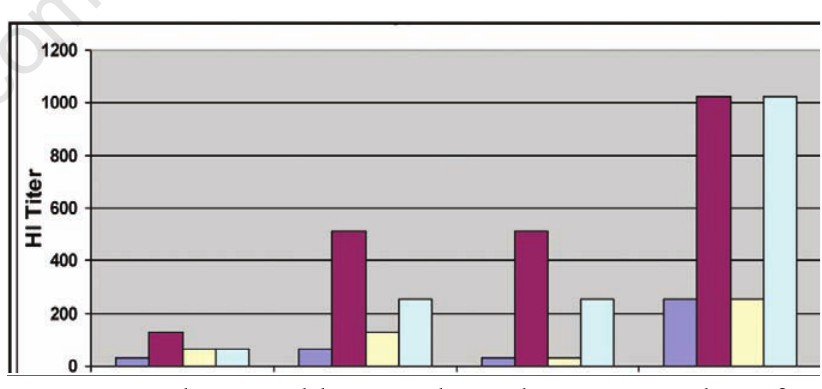
Figure 1. Hem-agglutination inhibition titer showing the antigenic interrelation of H9 subtype virus isolated in lahore in 2009. Table 3. Hemagglutination inhibition activity of pakistani h9 subtype avian influenza